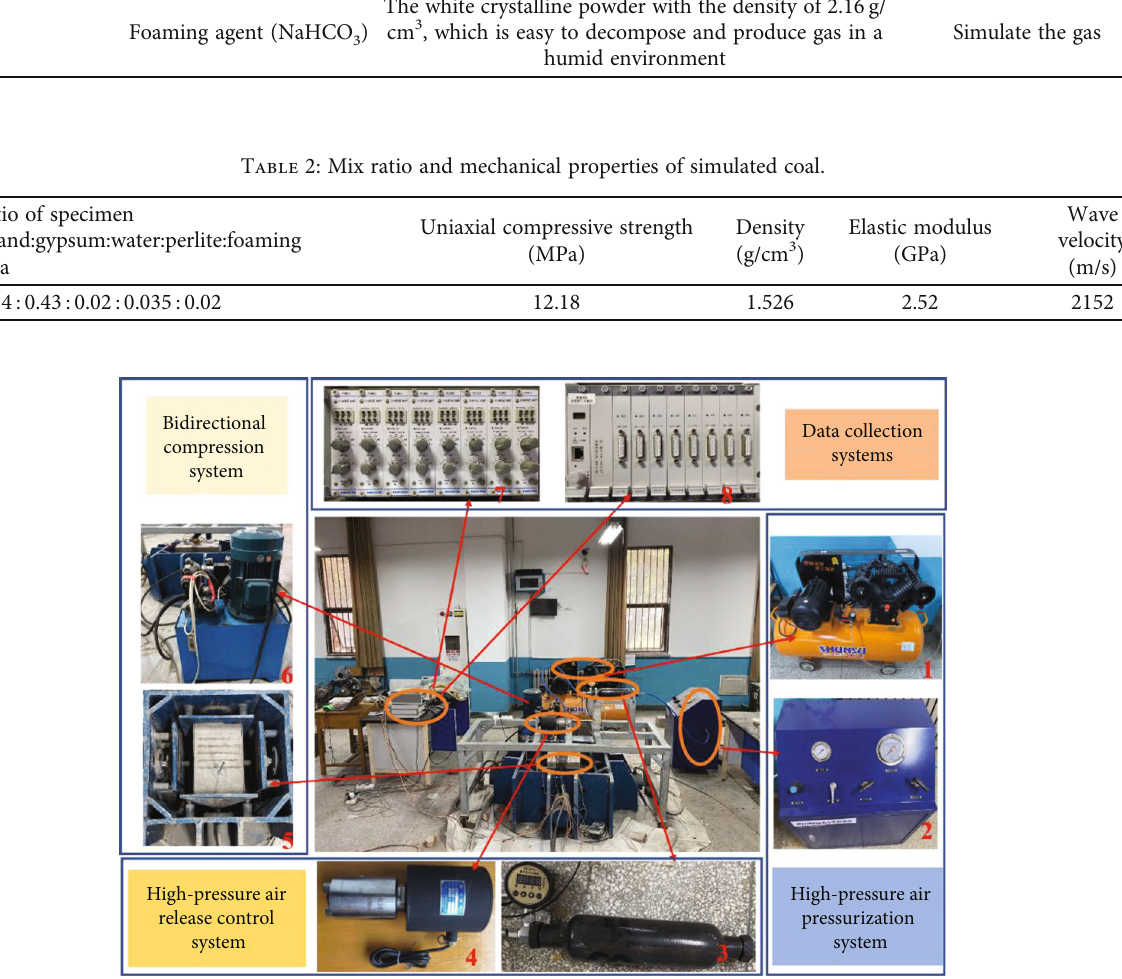
Figure 1: HPAB test system. 1: air compressor; 2: air booster pump; 3: autoclave; 4: dynamic strain gauge; 4: high-speed solenoid valve; 5: bidirectional compression system; 6: con fi ning pressure device; 7: Ye5853A signal ampli fi er; 8: DH5922N dynamic strain